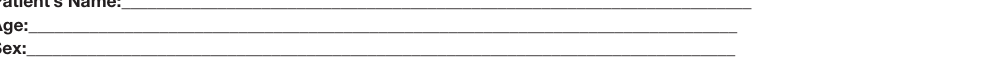
TABLE 2 | Thrombosis risk factor